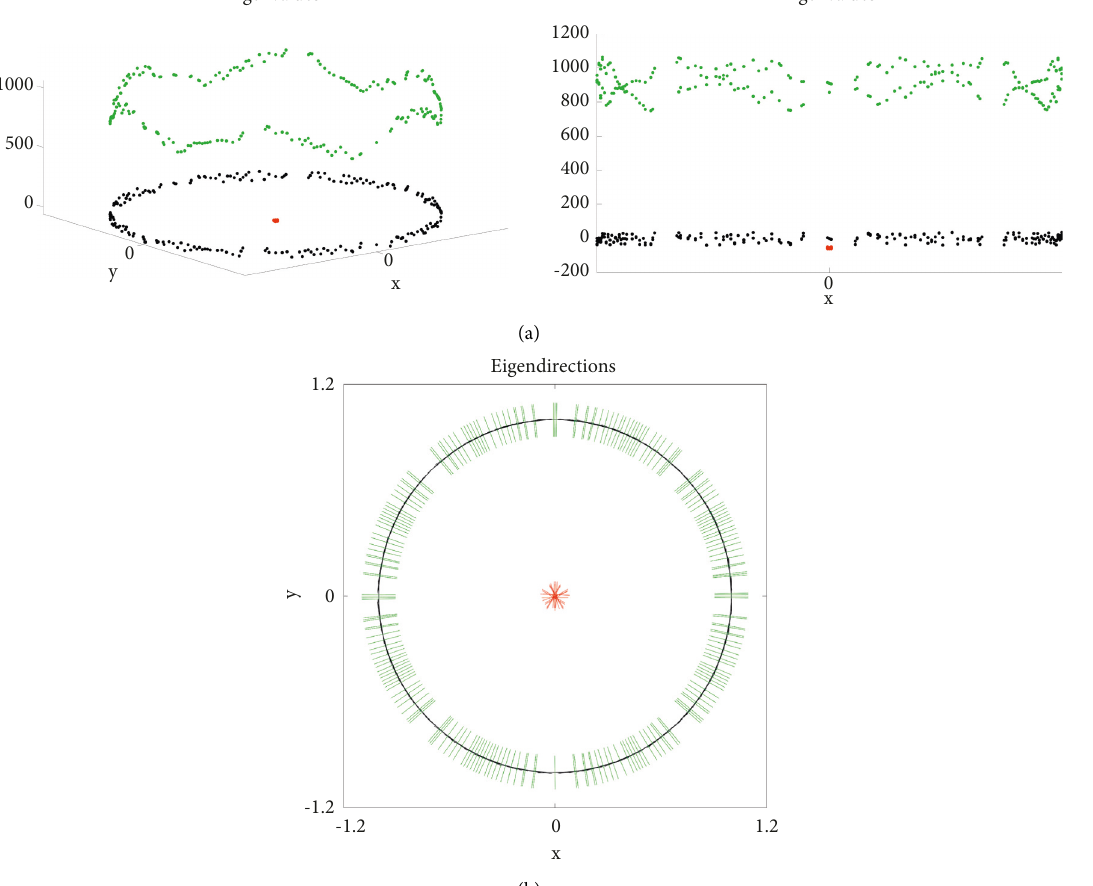
Figure 2: System (18). (a) Eigenvalues of the Hessian at points of the chain recurrent set: green (positive, attractive), black (zero, neutral), and red (negative, repelling). (b) Corresponding eigendirections, indicating attractive, repelling, and neutral directions to the connected component of the chain recurrent set. The periodic orbit has a 1-dimensional neutral direction and a 1-dimensional attractive one, while the equilibrium has a 2-dimensional unstable